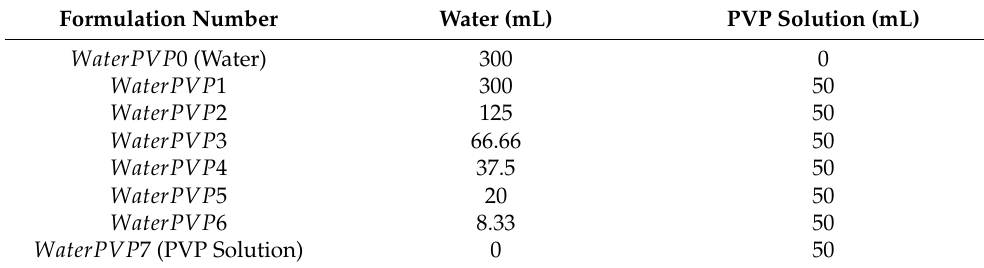
Table 1. The different formulations applied for the samples preparation.